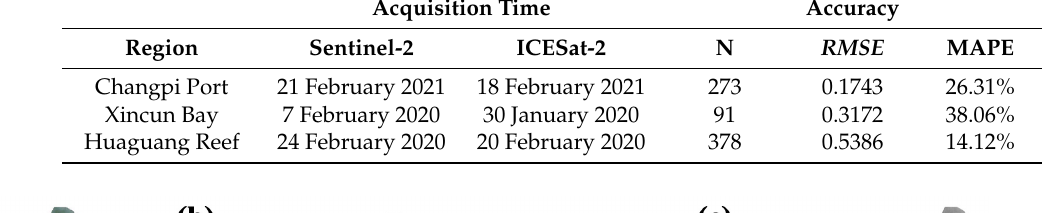
Table 3. The Acquisition Time of Sentinel-2 and ICESat-2 and the Accuracy Assessment for Three Regions. Acquisition Time